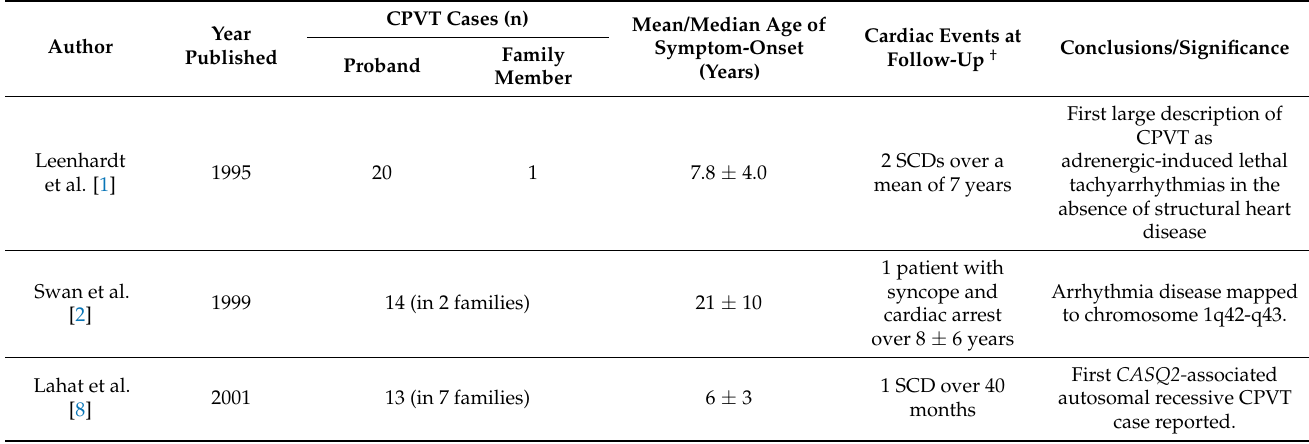
Table 2. Cohort studies of pediatric CPVT